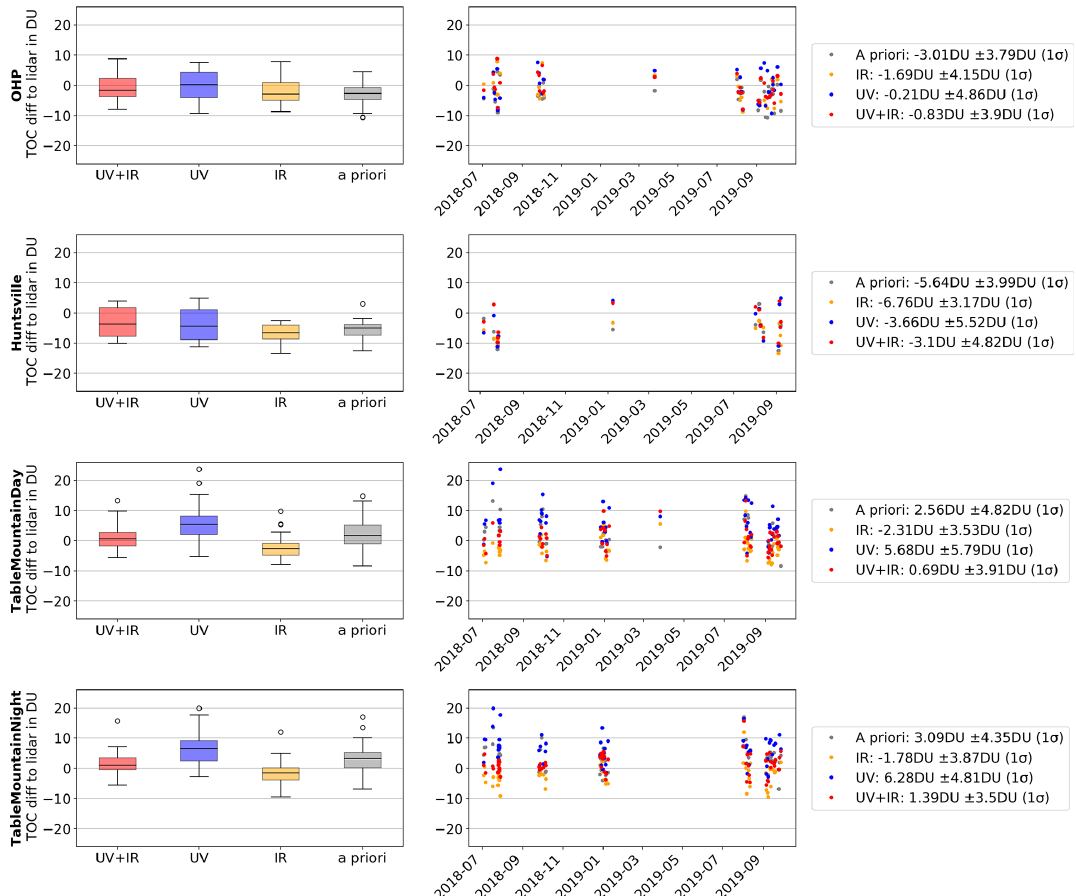
Figure 6. Absolute differences in the TOC with respect to the tropospheric lidar data. The differences are shown as box-and-whisker plots in the left panels and as time series in the middle panels. The right panels show statistical information (mean absolute differences and the standard deviations). TOCs are calculated by integrating ozone profiles from the lowermost retrieval level altitude up to the tropopause. The height of the tropopause is obtained from the ERA5 reanalysis data using the 2PVU